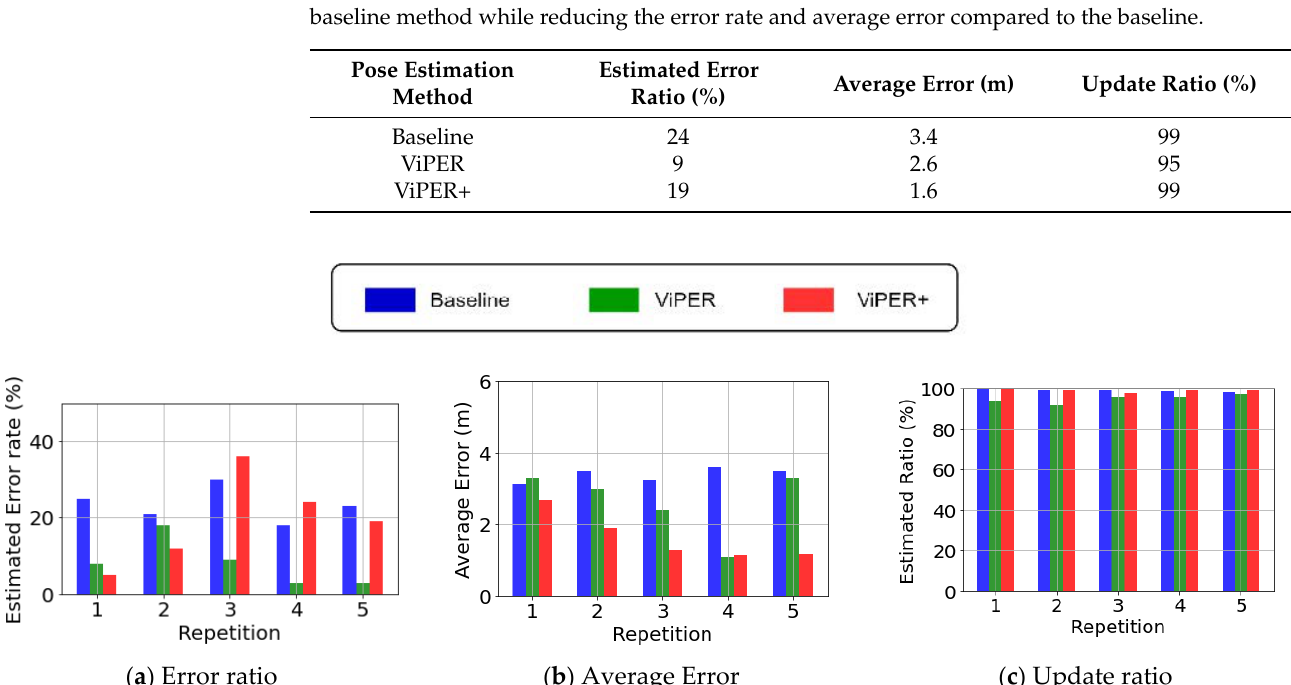
Figure 8. Results of vehicle tracking for scenarios without blocking objects. Using ViPER reduces the error rate in the pose estimation of the vehicle compared to the other two methods.